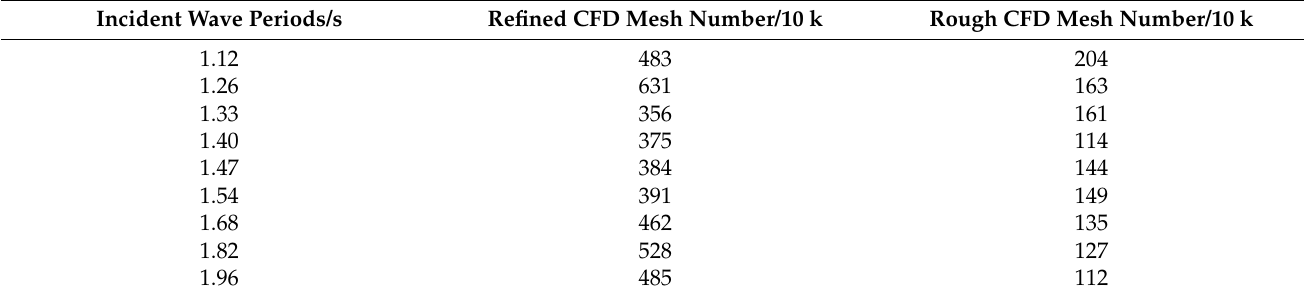
Table 7. Mesh numbers for different